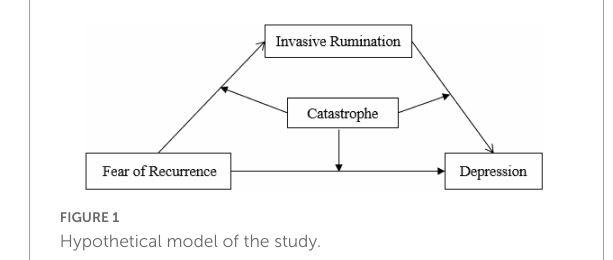
FIGURE1 Hypothetical model of the